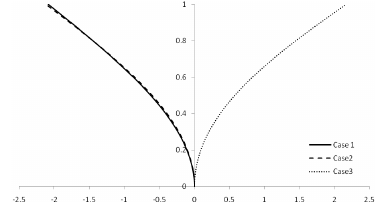
Figure 8. Modeshapes for the second mode – exponential variation.